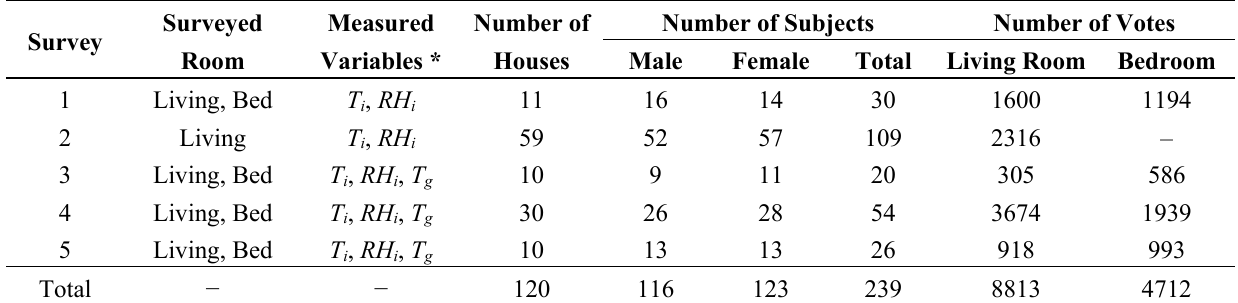
Table 2. Description of survey for summer (2010 to 2014).